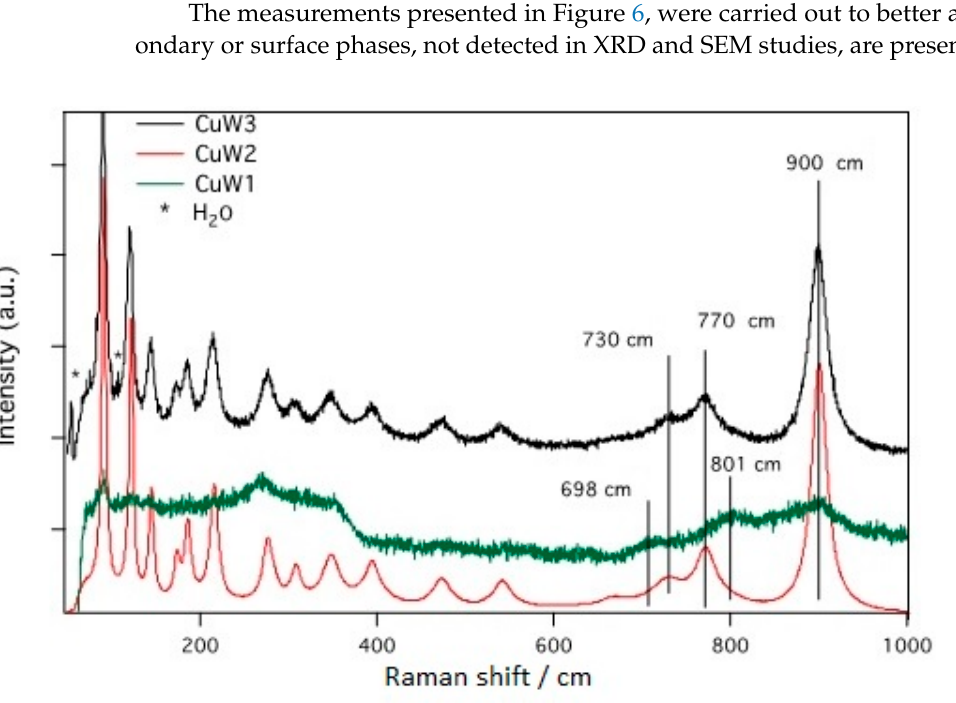
Figure 6. The short-range structural ordering in the lattice of our samples analyzed via Raman spectroscopy.